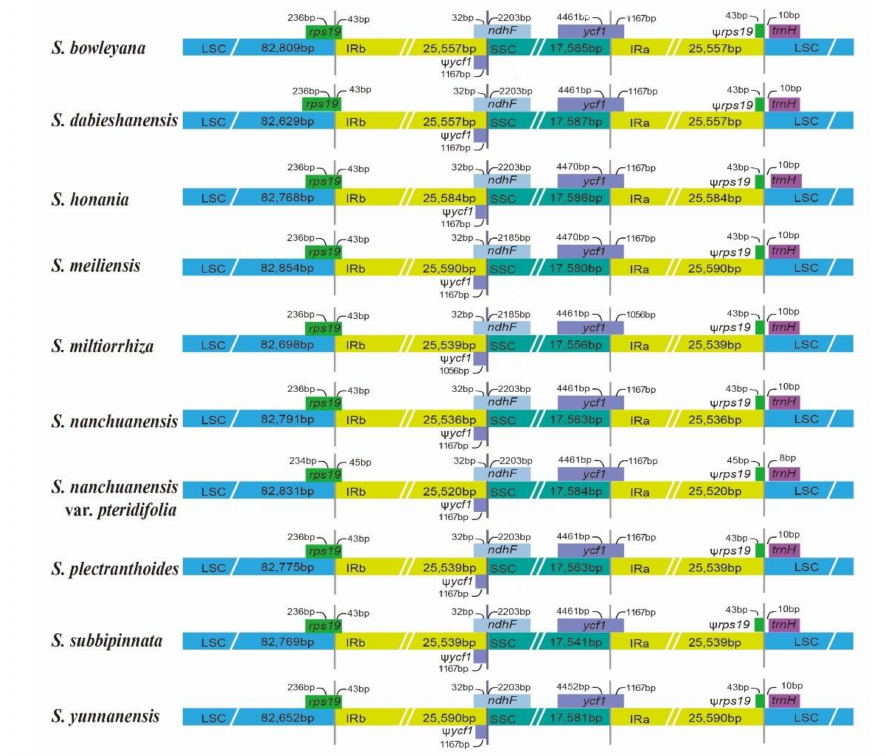
Figure 6. Comparison of junctions between the LSC, IR, and SSC regions among plastomes of 10 taxa of Salvia sect. Drymosphace . Genes are denoted by colored boxes, with ψ indicating a